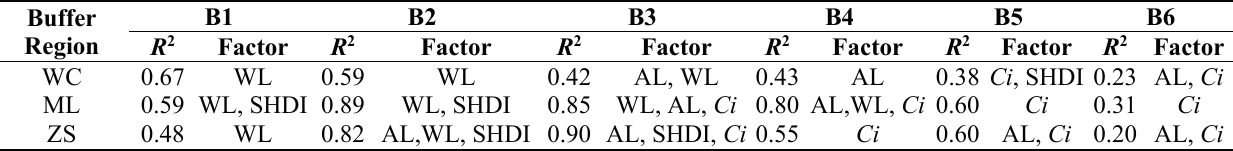
Table 4. Modeling result of LUCC and algae area as three divisions considered separately. Buffer